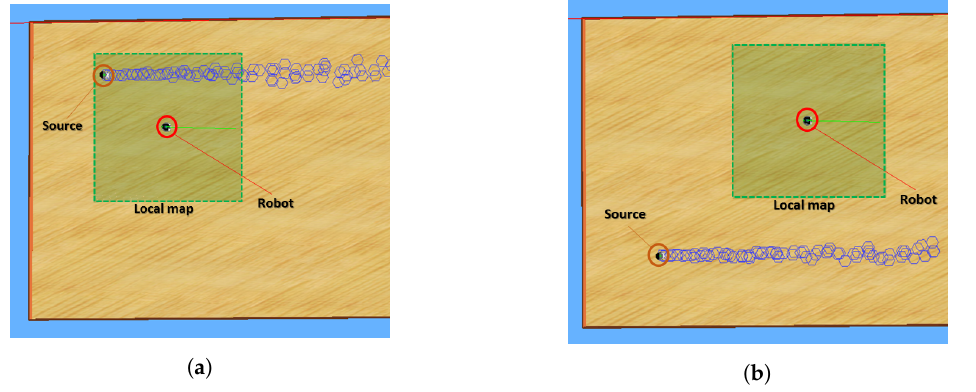
Figure 2. Position of the local map with respect to the source and the plume: ( a ) source inside the local map of the robot and ( b ) local map outside the